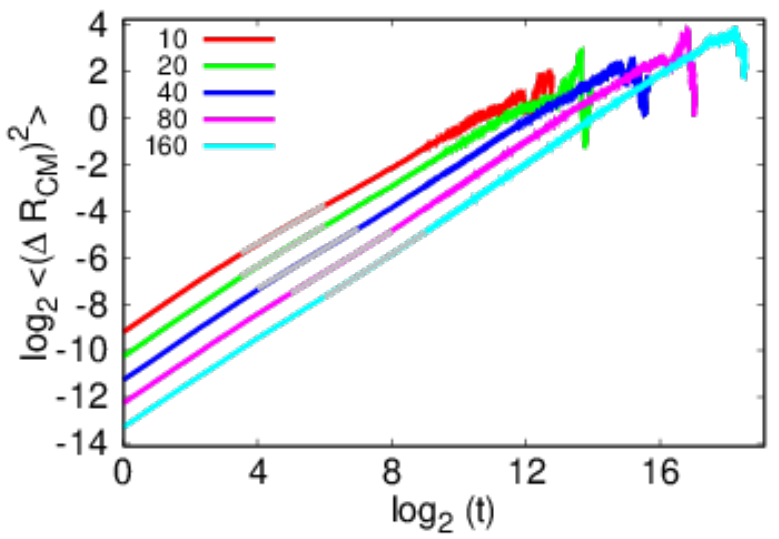
Figure 9. Time dependence of the log mass relative to its initial position.